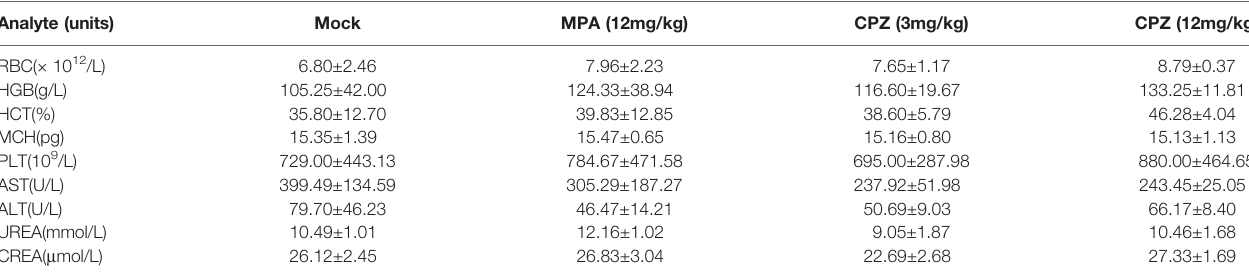
Data shown represent means ± standard deviation. RBC, red blood cells; HGB, hemoglobin; MCH, mean cell height; HCT, hematocrit; PLT, platelets; AST, aspartate aminotransferase; CREA, creatinine; UREA, carbamide; ALT, alanine